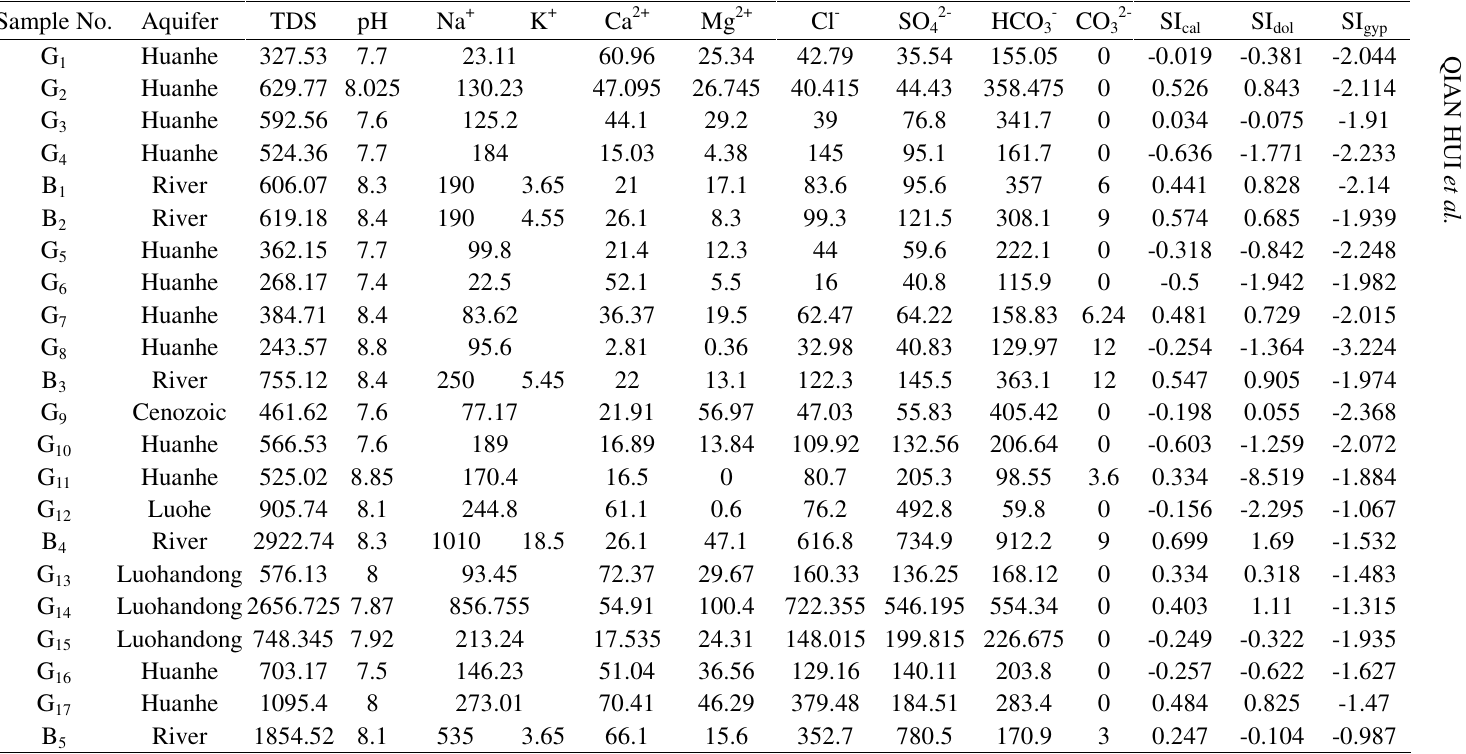
Table 1. Chemical analysis results of Dousitu river water and nearby groundwater (Unit: mg/L) Sample